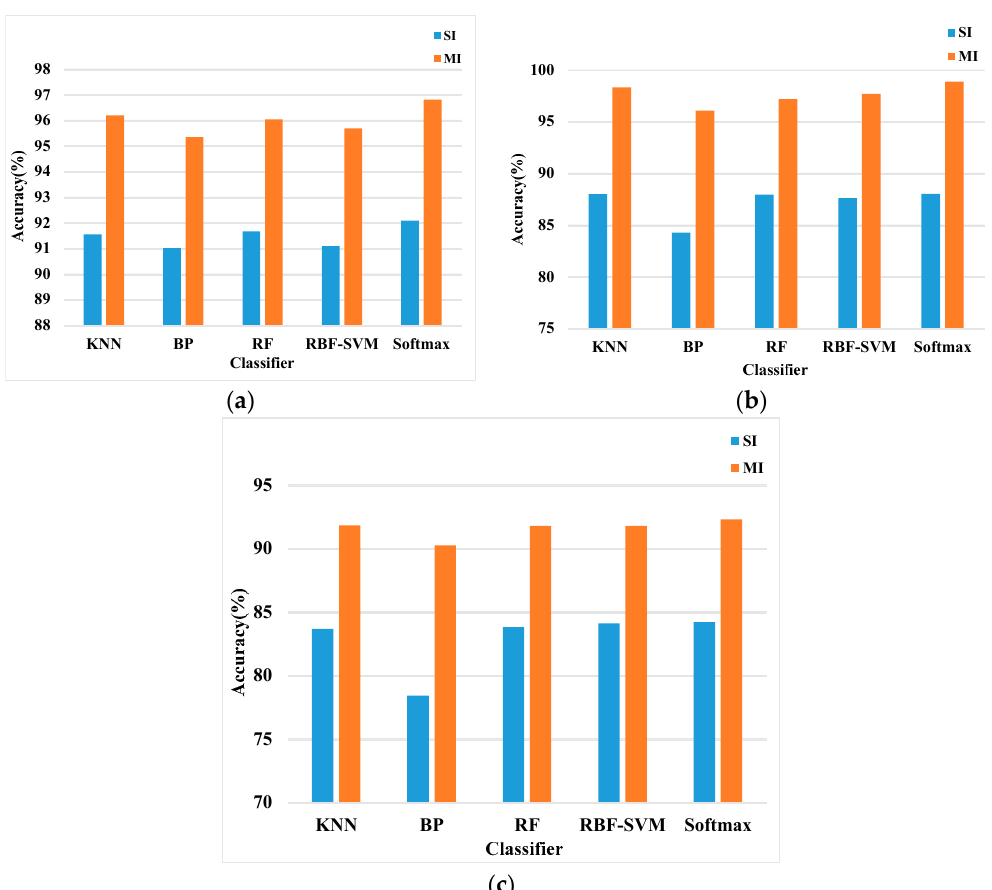
Figure 11. Comparison of di ff erent classifiers using the proposed method. ( a ) Classification results of di ff erent classifiers on the MIT-BIH-AHA database; ( b ) Classification results of di ff erent classifiers on the ECG-ID database (Two-recording); ( c ) Classification results of di ff erent classifiers on the ECG-ID database (All-recording).